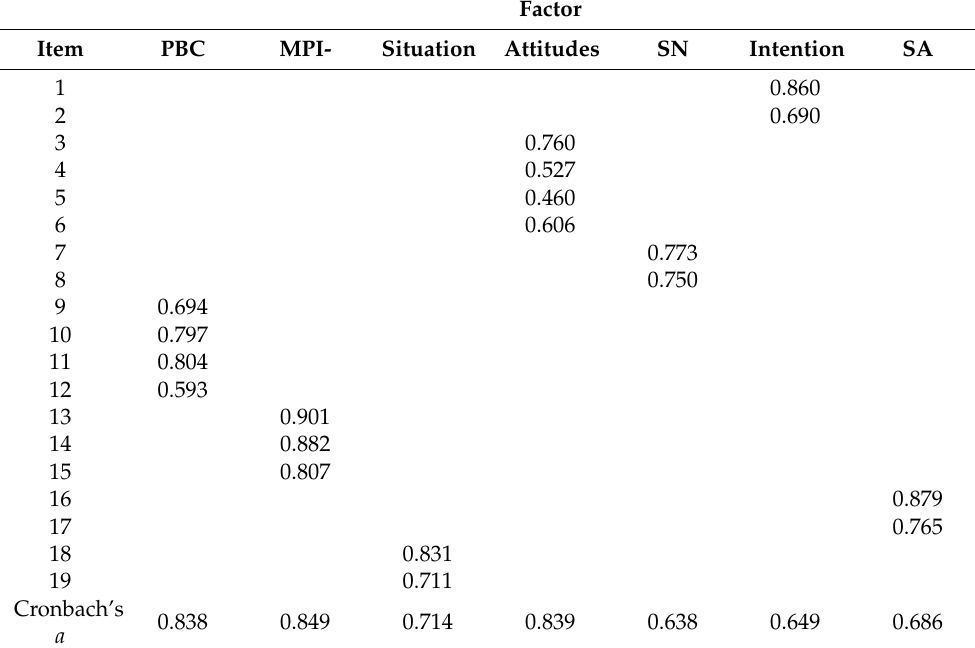
Table 3. Principal component analysis and Cronbachs.